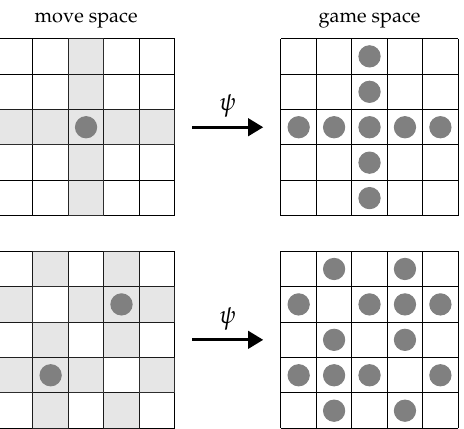
Figure 5. Two examples of mapping a sequence of moves in the move space K to a game in the game space G via the homomorphism ψ for two-state Alien